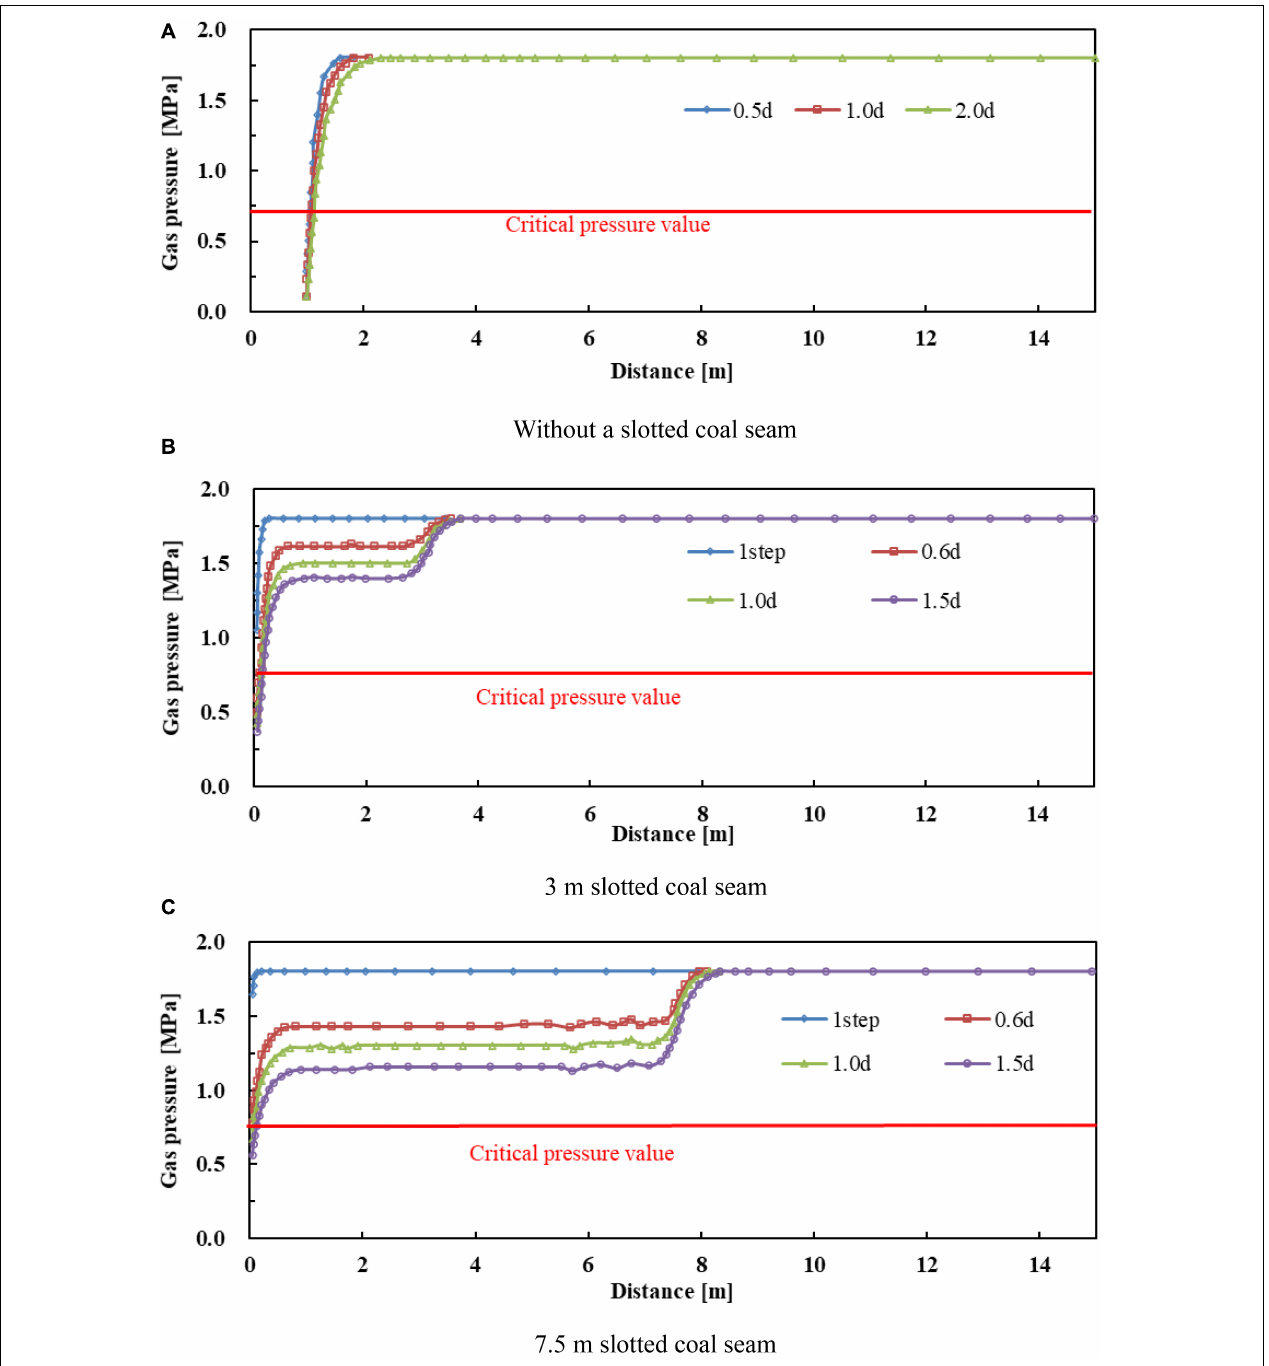
FIGURE 10 | Variation in gas pressure: (A) without a slotted coal seam, (B) 3-m slotted coal seam, and (C) 7.5-m slotted coal